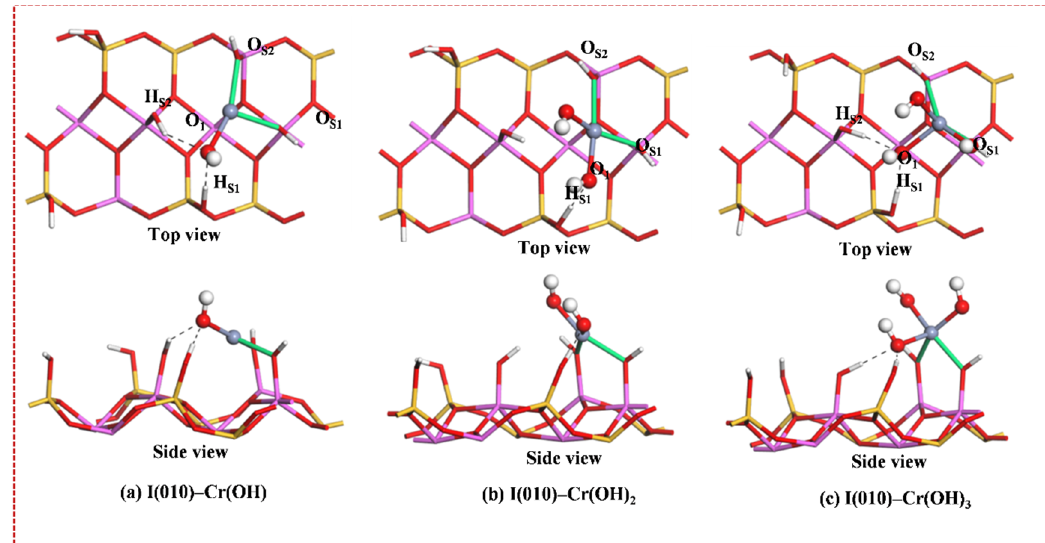
Figure 3. Stable configurations of Cr(OH) n(3 − n)+ adsorbed on the illite (010) surface. Table 2. Calculated energy characteristics (kJ/mol) and structural parameters (Å) of Cr(OH) n(3 − n)+ adsorbed on the illite (010)